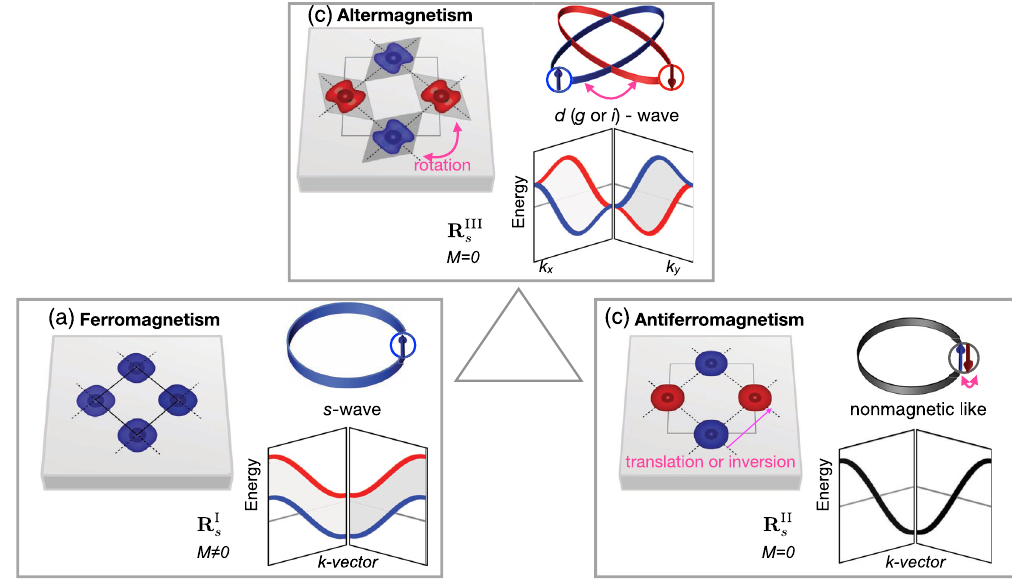
FIG. 1. Illustrative models of collinear ferromagnetism, antiferromagnetism, and altermagnetism in crystal-structure real space and nonrelativistic electronic-structure momentum space. (a) Ferromagnetic model with one spin sublattice, and corresponding distinct spin-group form, nonzero magnetization, T -symmetry breaking momentum-independent spin splitting of bands, and isotropic s -wave spin-split Fermi surfaces. (b) Antiferromagnetic model with opposite-spin sublattices (red, blue) connected by inversion or translation, and corresponding distinct spin-group form, zero net magnetization, and T -invariant spin-degenerate bands reminiscent of nonmagnetic systems. (c) Altermagnetic model with opposite-spin sublattices connected by rotation and not by translation or inversion, and corresponding distinct spin-group form, zero net magnetization, T -symmetry breaking spin splitting with alternating sign, anisotropic sublattice spin densities, and anisotropic d ( g or i )-wave spin-split Fermi surfaces. See Sec. II B for the definitions of the distinct spin-group forms R i s